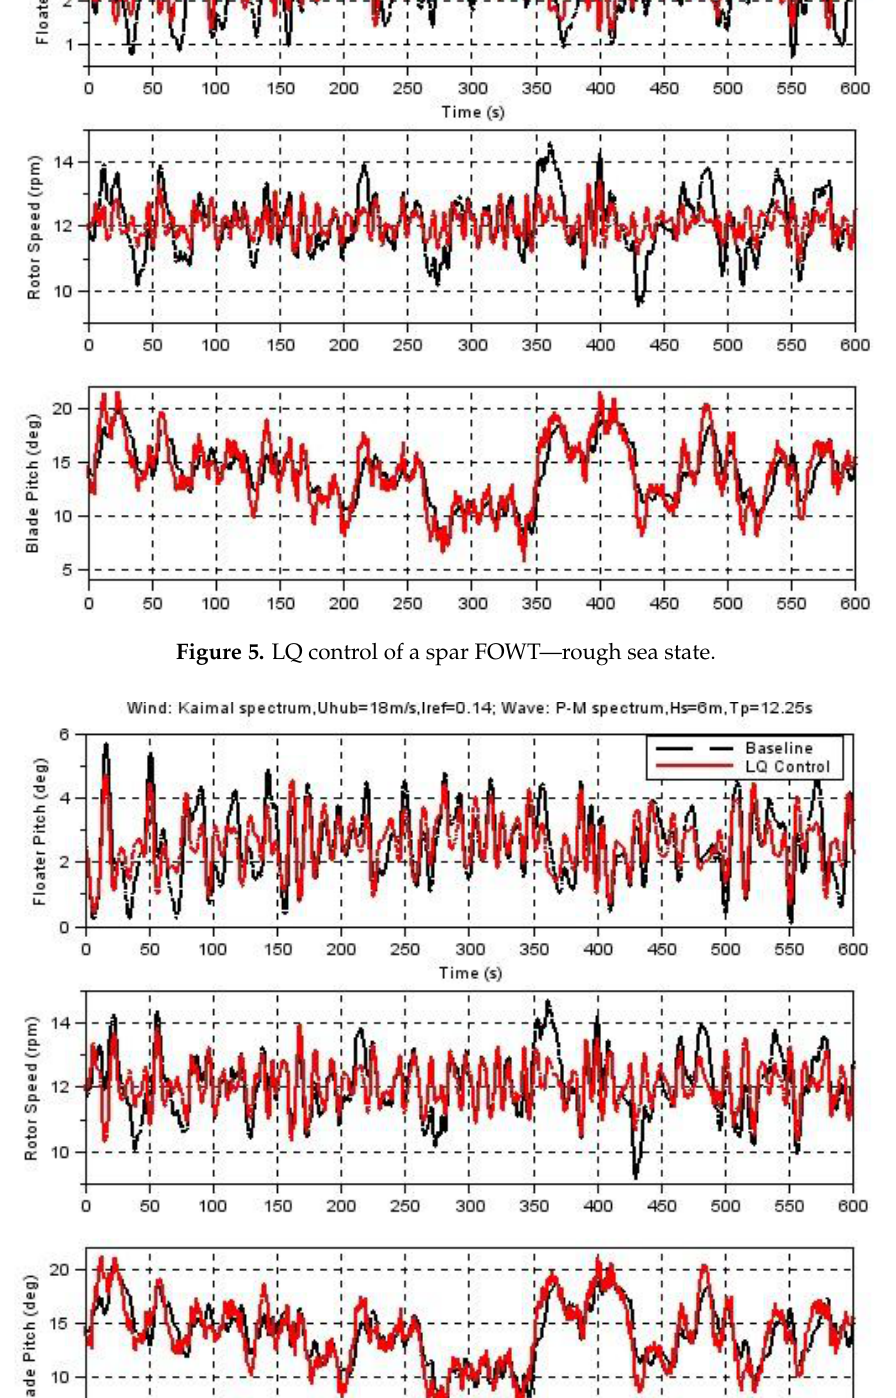
Figure 6. LQ control of a spar FOWT—very rough sea state.